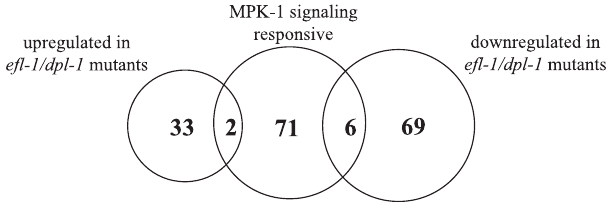
Figure 6. MPK-1 and EFL-1/DPL-1 Do Not Regulate the Same Set of Genes in the Germ Line MPK-1 signaling-responsive genes identified in this study have minimal overlap with candidate down-regulated or up-regulated